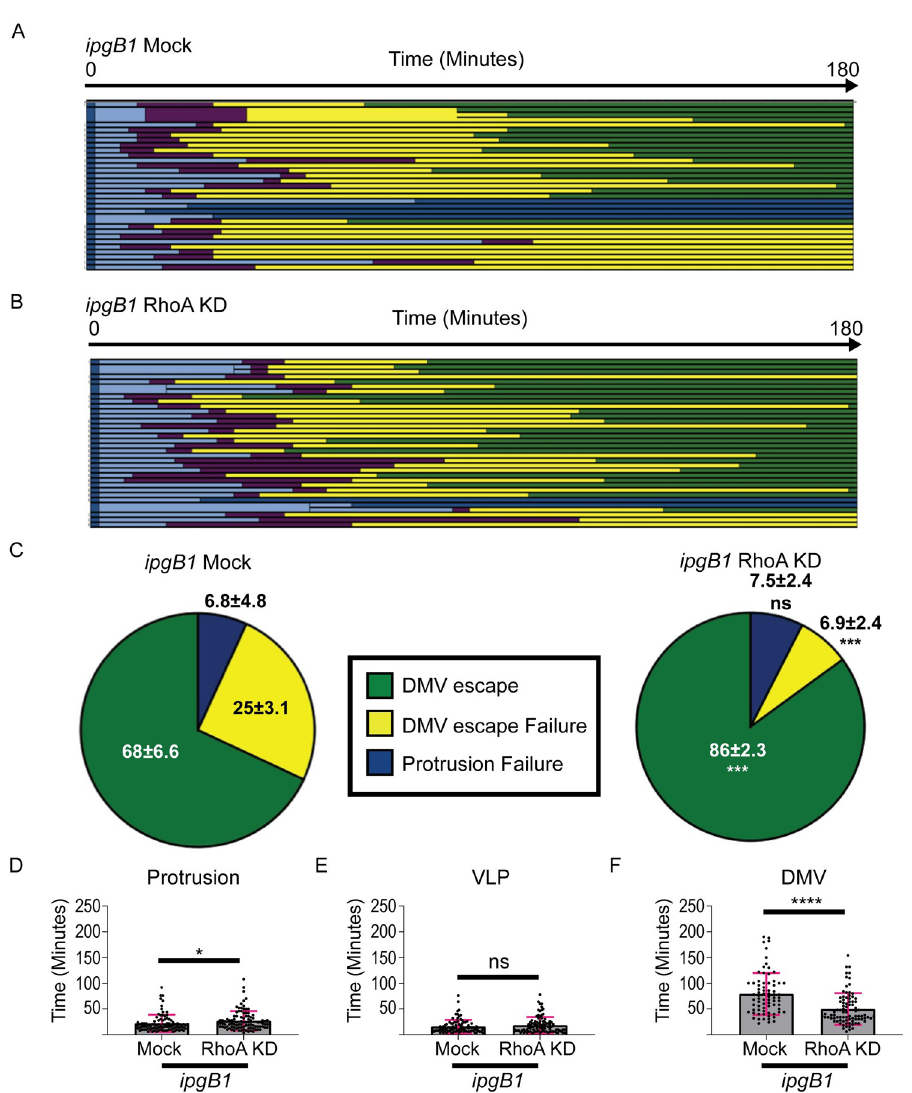
Fig 5. RhoA depletion restores ipgB1 DMV escape. (A and B) Representative tracking analysis of CFP-expressing ipgB1 bacteria in (A) mock-treated or (B) RhoA duplex 2-depleted HT-29 cells expressing plasma membrane-targeted YFP. Each bar represents the tracking of a single bacterium over 180 minutes. Thicker bars indicate instances when bacteria divided and branched during spreading. At least 30 bacteria were tracked for condition per biological replicate. (C) Graphs showing the proportions of fates of tracked bacteria from three biological replicates. Standard deviations of the means are indicated. Two-way ANOVA with Sidak’s multiple comparisons was performed; ns, not significant; ��� , p < 0.001. Time spent in protrusions (D), VLPs (E), or DMVs (F) is shown for all tracked bacteria. Each dot represents a single bacterium and the grey bars show the mean of all tracked bacteria from three biological replicates. Error bars indicate standard deviation. Unpaired two-tailed t-tests were performed; ns, not significant; � , p < 0.05; ���� , p <